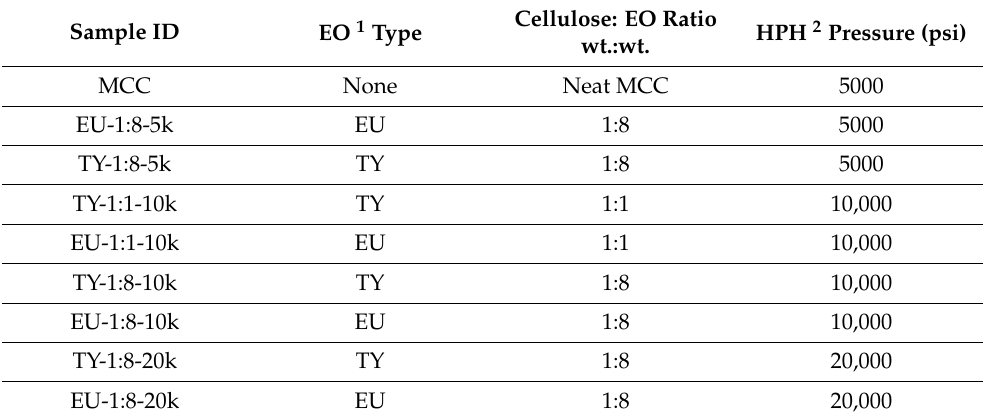
Table 1. Emulsions